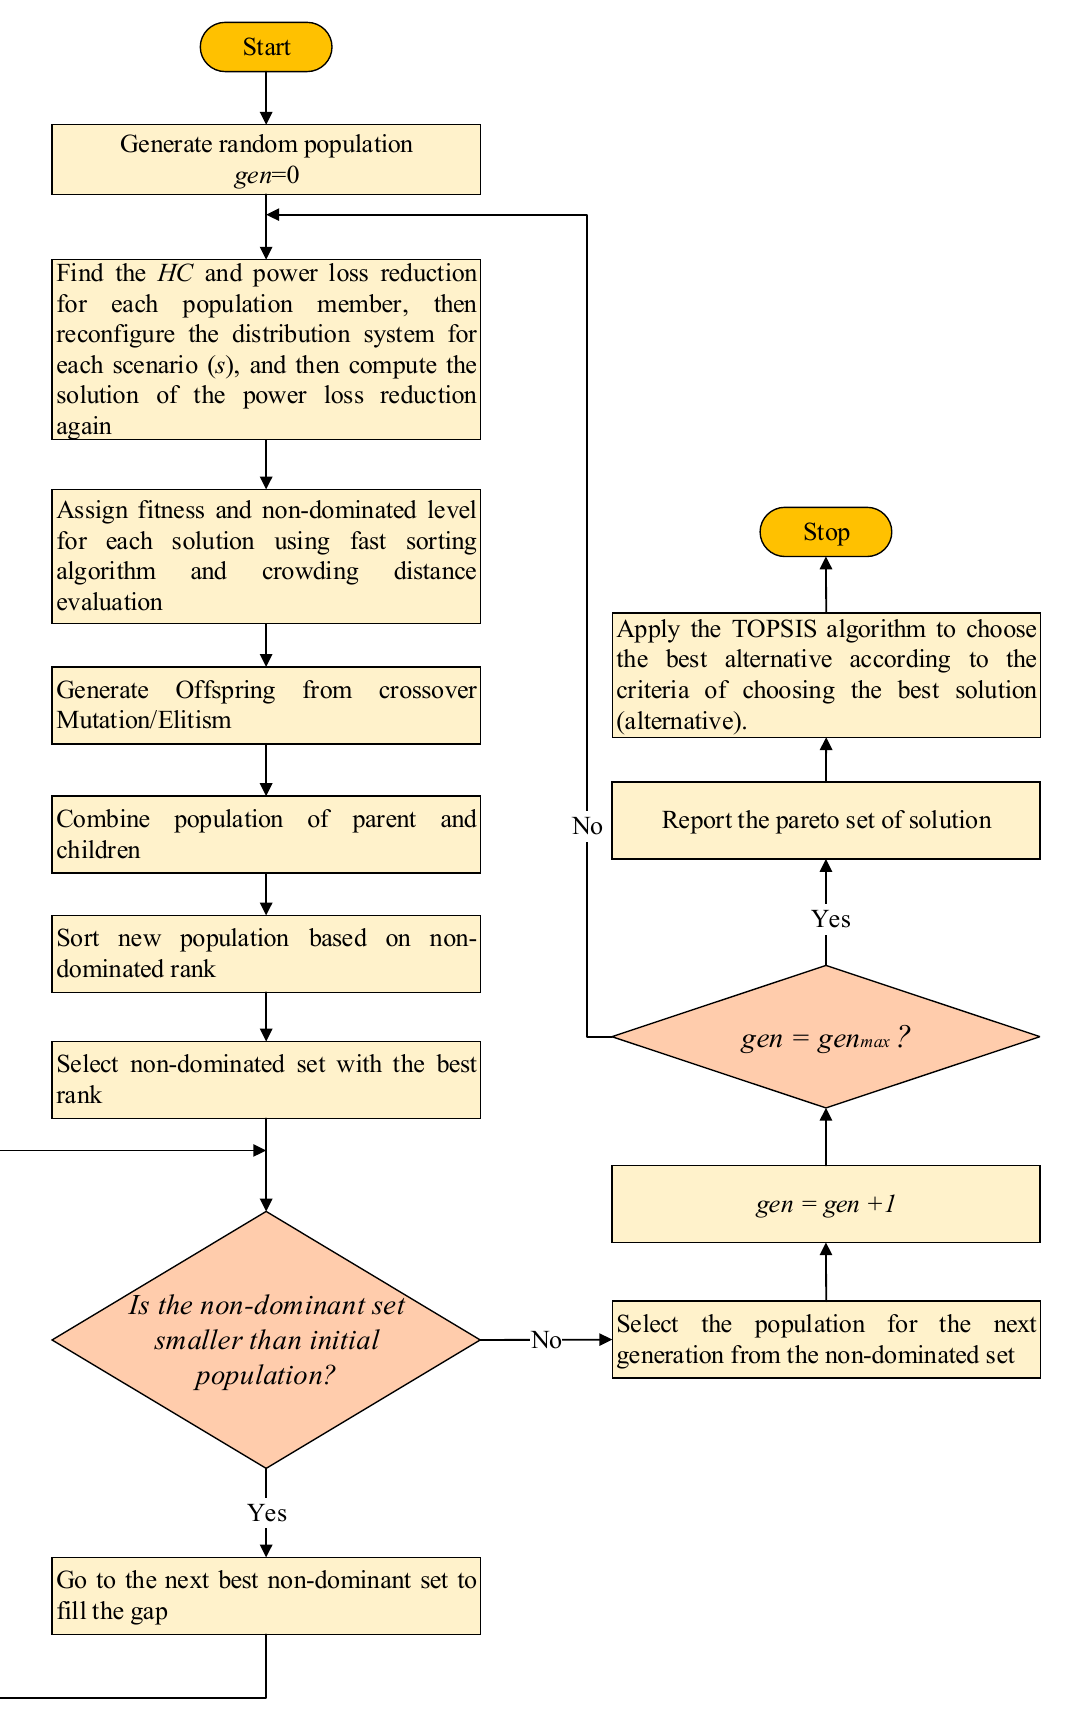
Figure 9. Flowchart of the non-dominated sorting genetic algorithm (NSGA-II) optimization algorithm.